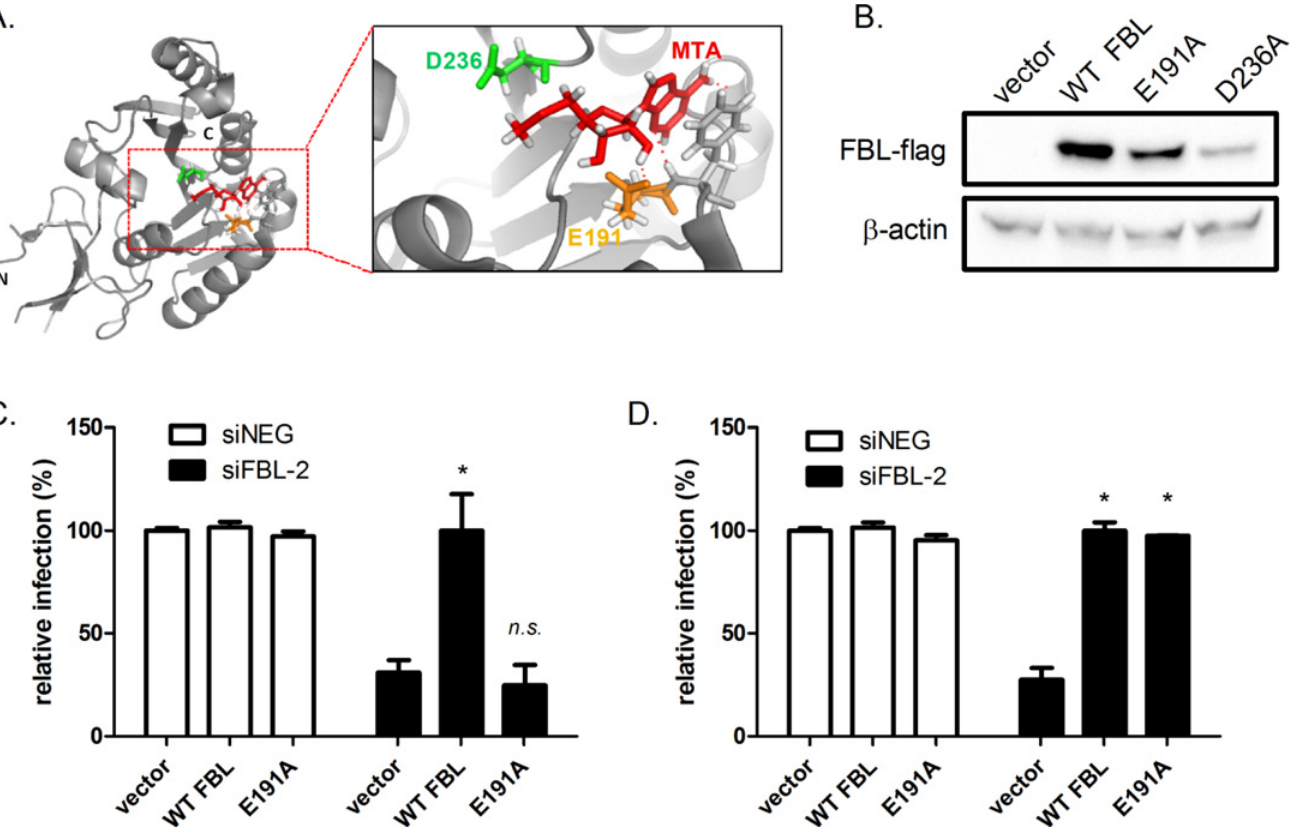
Fig 7. The catalytic activity of FBL is required for HeV infection but not RSV infection. (A) Crystal structure of human FBL (RCSP Protein Databank 2IPX) in complex with 5 ‘ -deoxy-5'-methylthioadenosine (MTA) (red), an analog of the natural cosubstrate factor S -adenosylmethionine (SAM). (http://www. rcsb.org/pdb/explore/explore.do?structureId=2IPX). The two conserved residues critical for co-substrate binding are shown. Red lines depict polar contacts between MTA and the huFBL molecule. E191 (orange) and D236 (green) were each substituted with alanine. (B) Protein expression levels of FBL variants assessed by Western blotting of HeLa cell lysates, using an anti-FLAG antibody. HeV infection (C) and RSV infection (D) in HeLa cells depleted of endogenous FBL +/- a vector (pCMV2, 500 ng, 24 h) expressing FBL resistant to siRNA carrying the E191A mutant, followed by HeV infection (MOI 0.1, 24 h). * p < 0.05 compared to